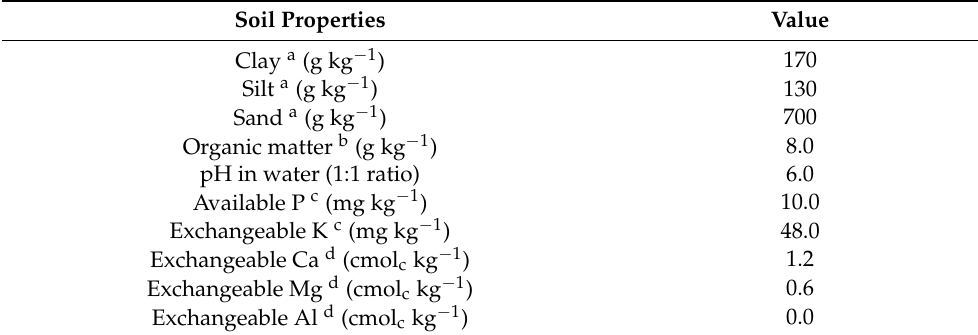
Table 1. Physical and chemical soil characterization in the 0–0.2 m soil layer in the experimental site, before study